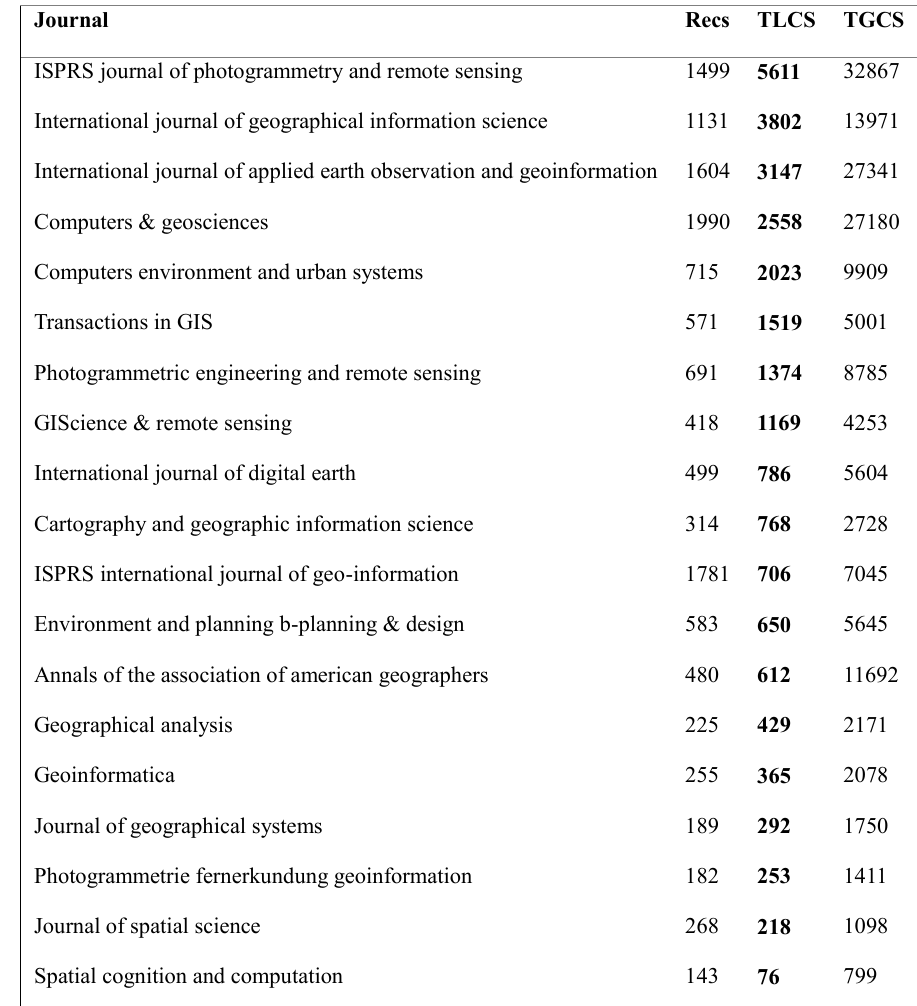
Table 1. Journals ranked in domain